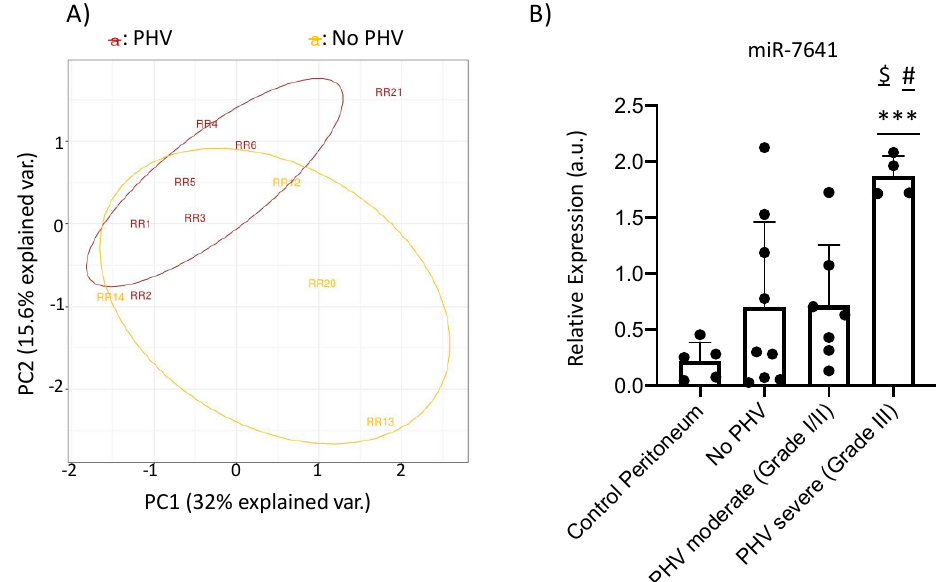
Figure 6. ( A ) Principal component analysis showing dissociation between PHV and no PHV groups. ( B ) Relative miR-7641 expression between samples. Data are represented as 2E(-dCt) as a measure of the relative amount of miR764. Graphic represents individual data points and the mean ± SEM. *** p < 0.001 vs. Control peritoneum, # p < 0.01 vs. No PHV group; $ p < 0.005 vs. PHV moderate group.